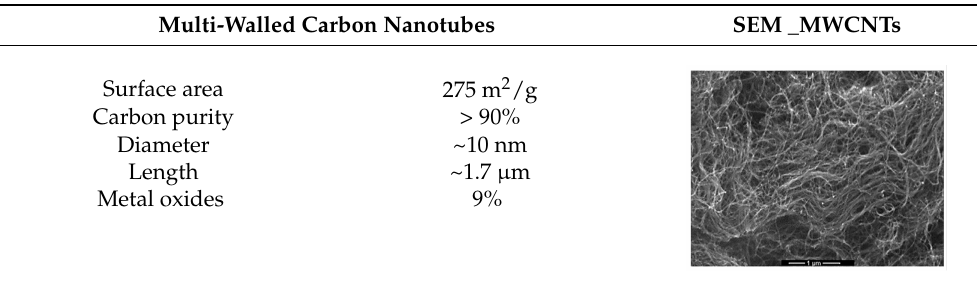
Table 2. Specifications of multi-walled carbon nanotubes